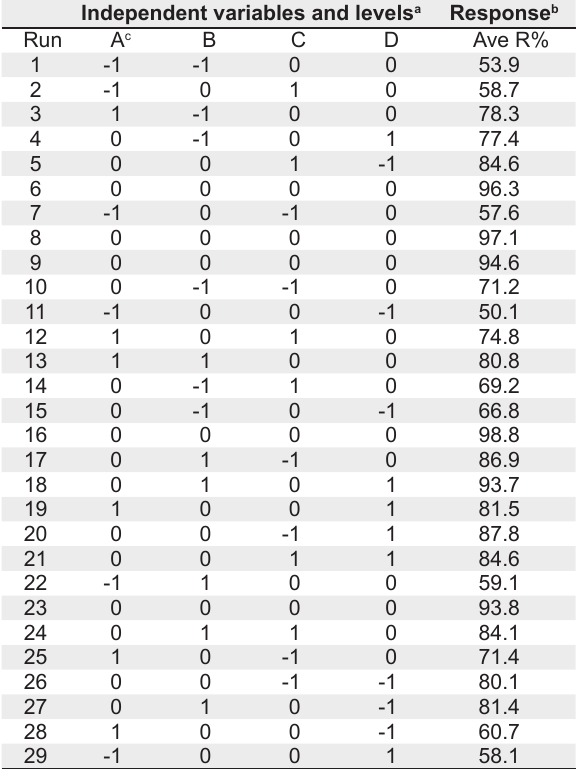
Table 2. Box-behnken design matrix and the response of the dependent variable aveage r covery of OCPs and PCBs.